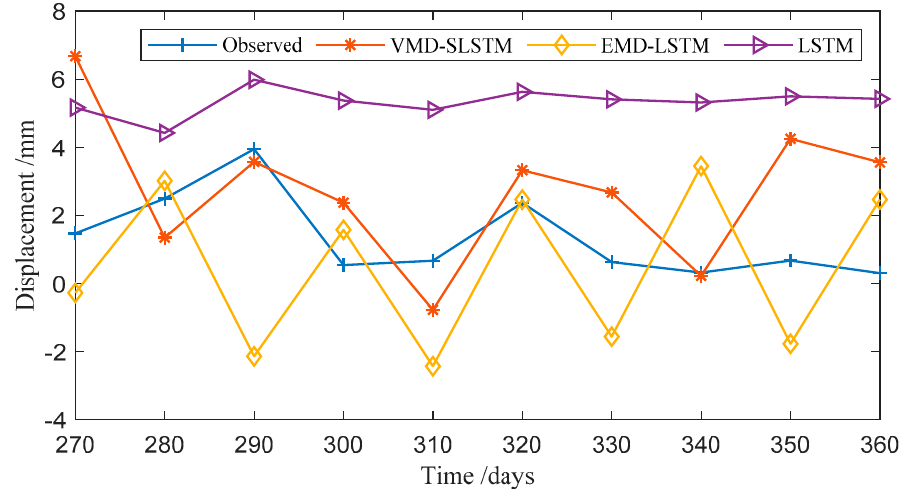
Figure 10. Forecast results of landslide displacement using three forecasting models: VMD-SLSTM, empirical mode decomposition (EMD)-SLSTM, and LSTM.